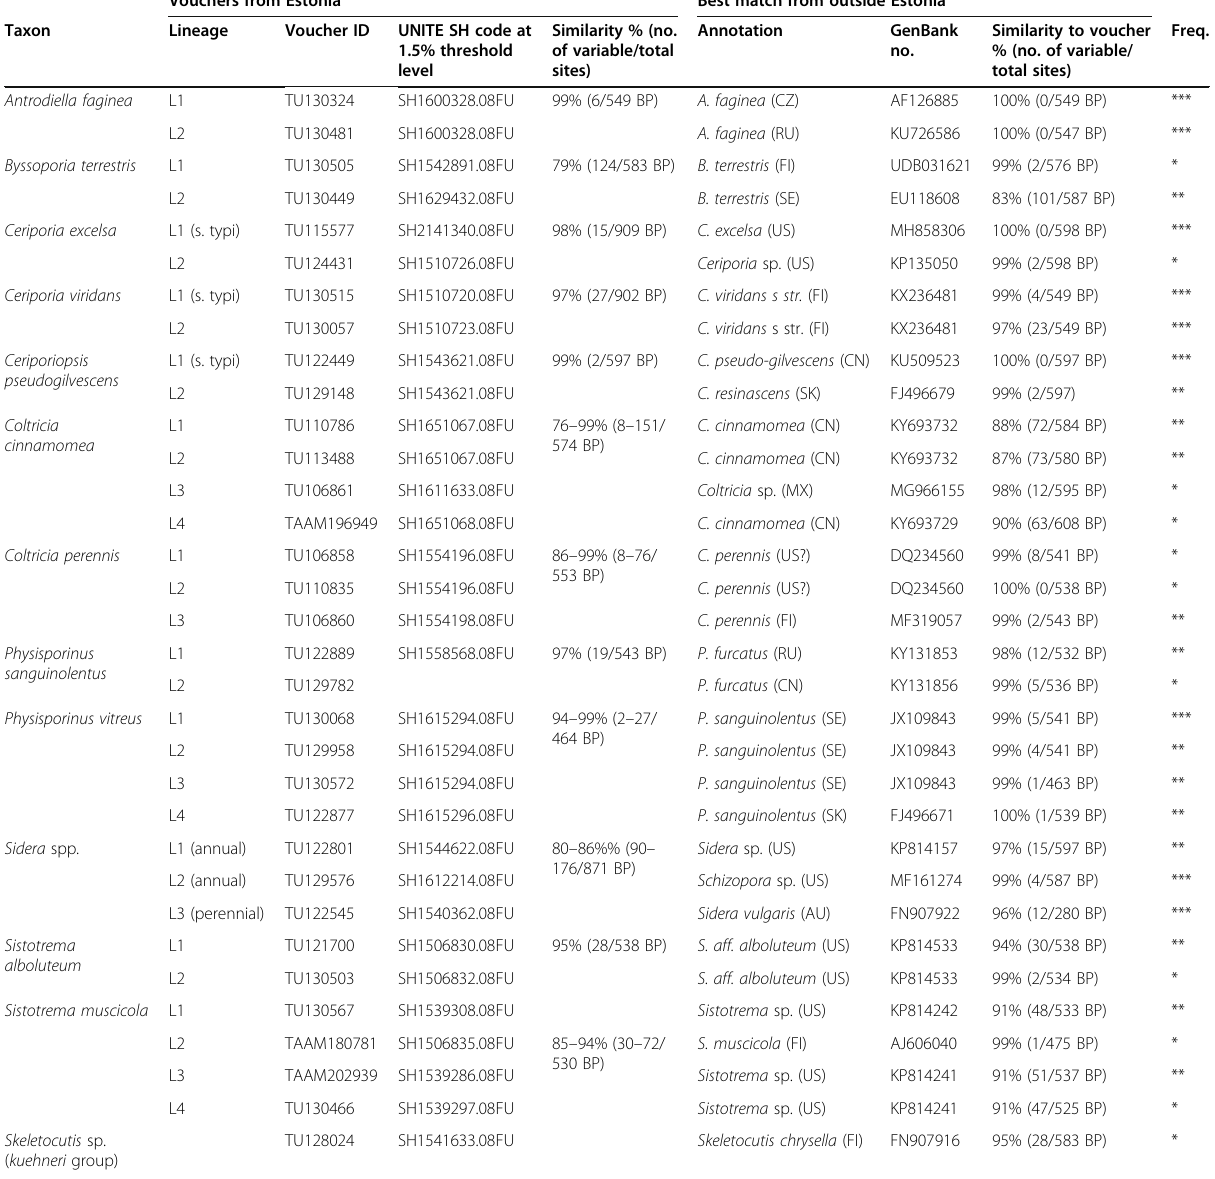
Table 3 Lineages of unnamed and/or collective polypore species in Estonia. Freq – no. of records in Estonia (* 1; ** 2 – 5; *** >